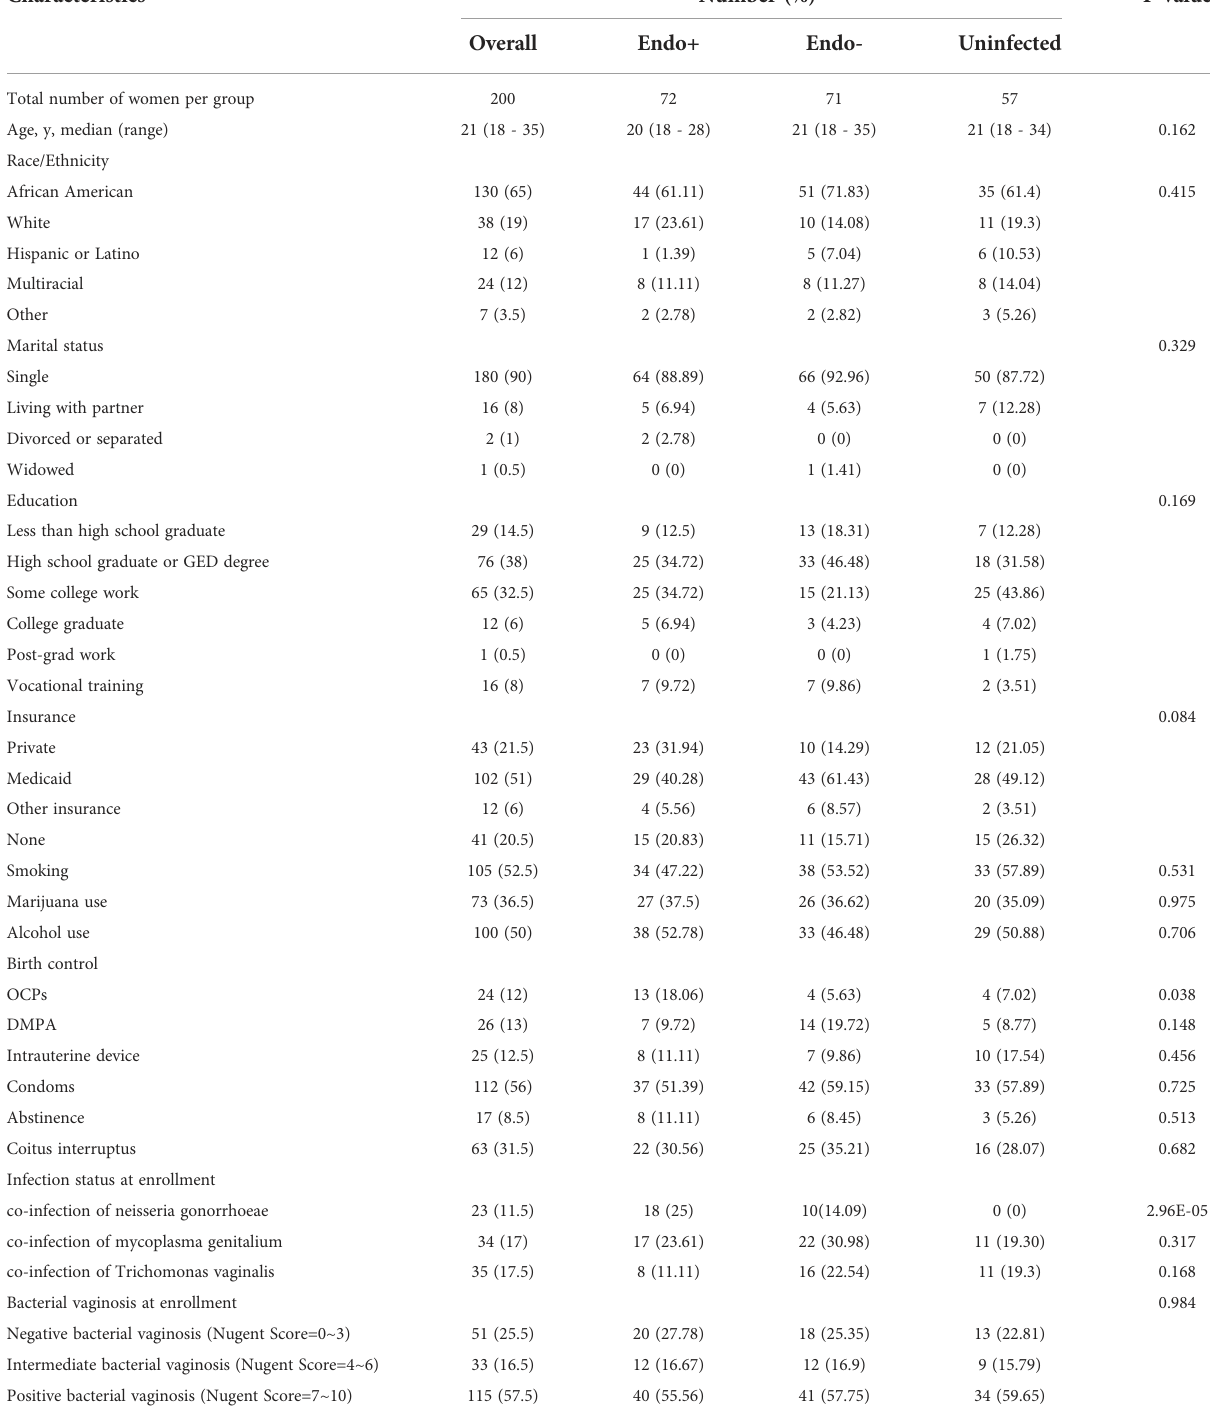
TABLE 1 Population